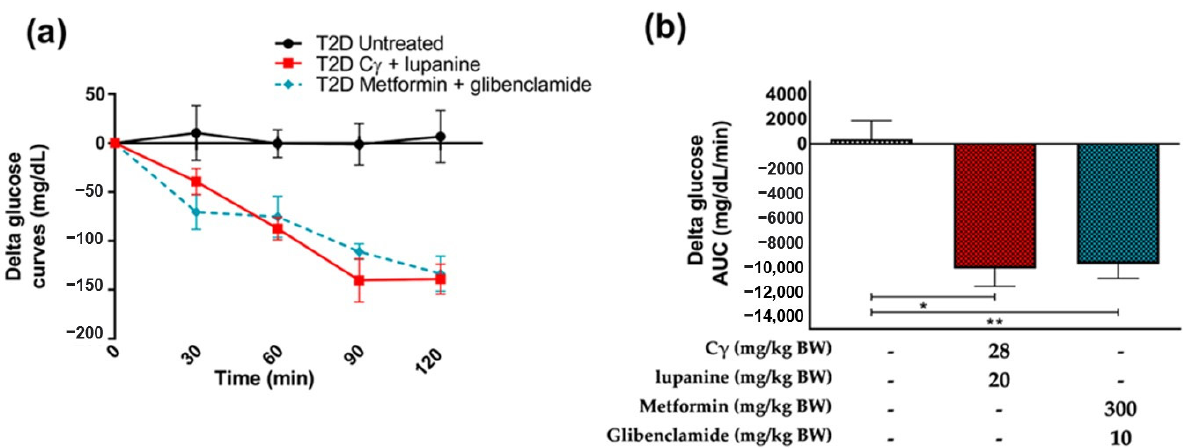
Figure 2. Comparison of acute treatment effects of C γ + lupanine versus metformin + glibenclamide. ( a ) Follow-up of blood glucose concentration in response to the treatments: 28 mg/kg BW C γ + 20 mg/kg BW lupanine and 300 mg/kg metformin + 10 mg/kg glibenclamide in diabetic rats, n = 4. Delta glucose curves at the different evaluated timepoints ( b ) Delta glucose AUC values. Data were analyzed using a paired t -test. * p < 0.05, ** p <